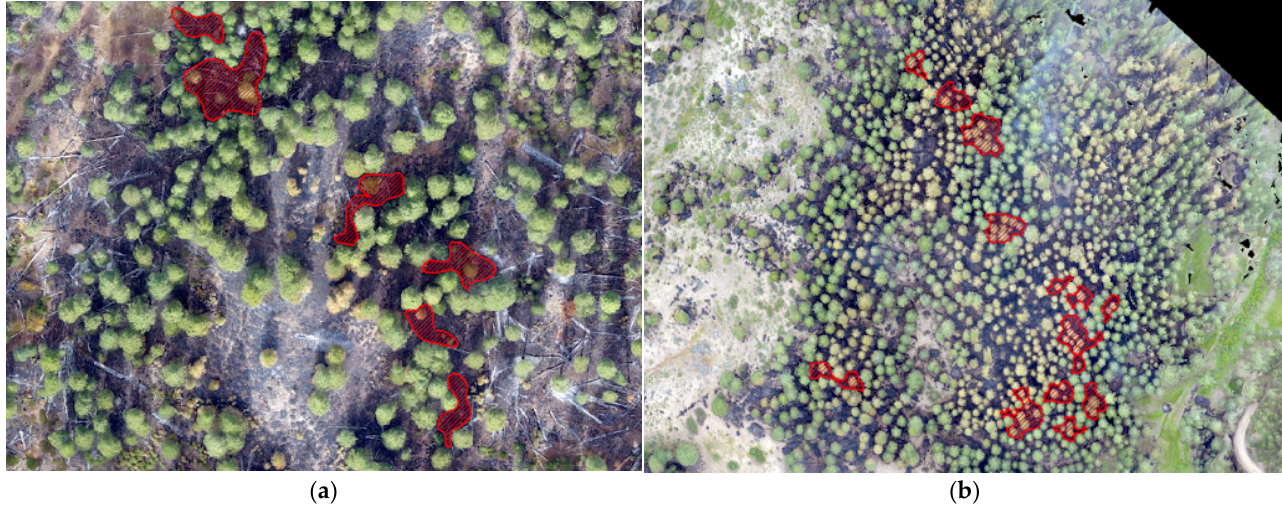
Figure 4. These images contain an orthomosaic with validation data overlaid on top. The polygons in red contain areas of burned surface vegetation and canopy cover that is burned underneath. These areas in red should be considered part of the burn extent, and these polygons were drawn to validate our classifications. ( a ) Image from the Cottonwood prescribed burn ( b ) Image from the Hoodoo prescribed burn.